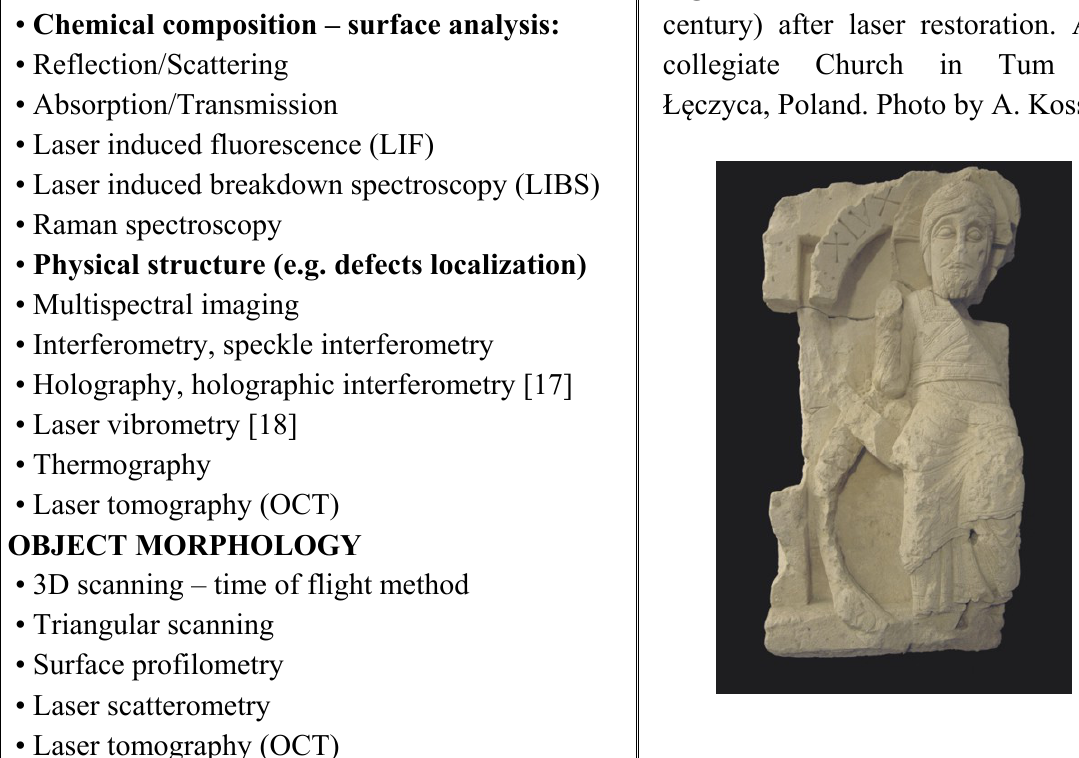
Figure 3. Christ Pantokrator (12 th century) after laser restoration. Arch-